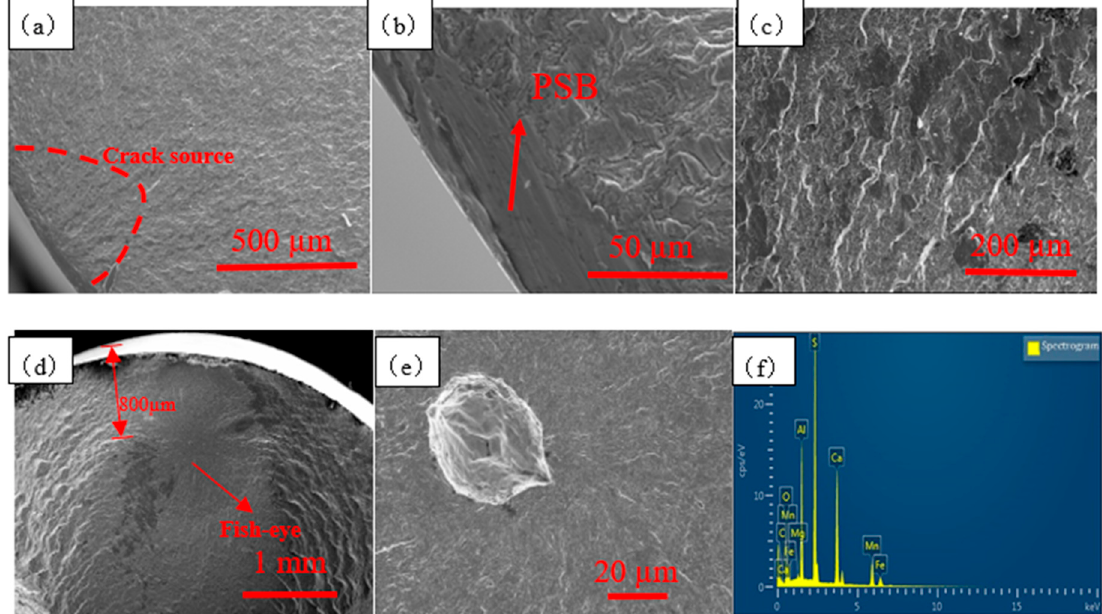
Figure 5. ( a ) the macroscopic diagram of fatigue fracture of Polishing, ( b )local amplification of fatigue fracture of Polishing, ( c ) local amplification of fatigue fracture of Polishing, ( d ) macroscopic diagram of fatigue fracture of AWJP + USRE ( e ) local amplification of fatigue fracture of AWJP + USRE and ( f )shows the energy spectrum of AWJP + USRE inclusions.